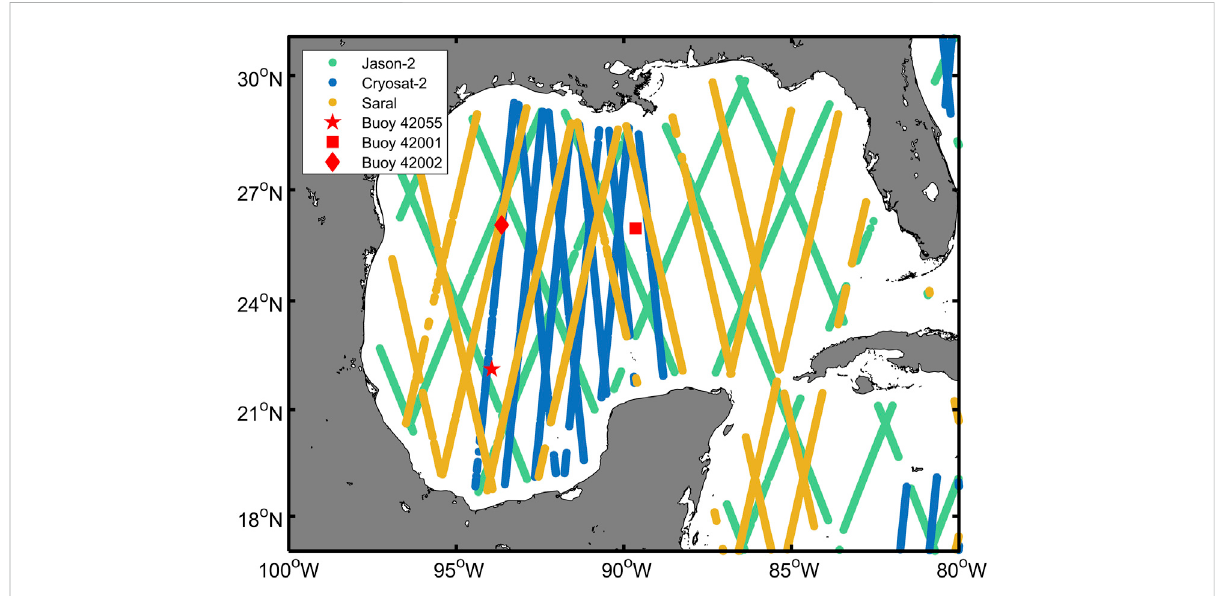
FIGURE 2 Satellite trajectories from 1st to 10th of January 2015 and NDBC buoy positions.